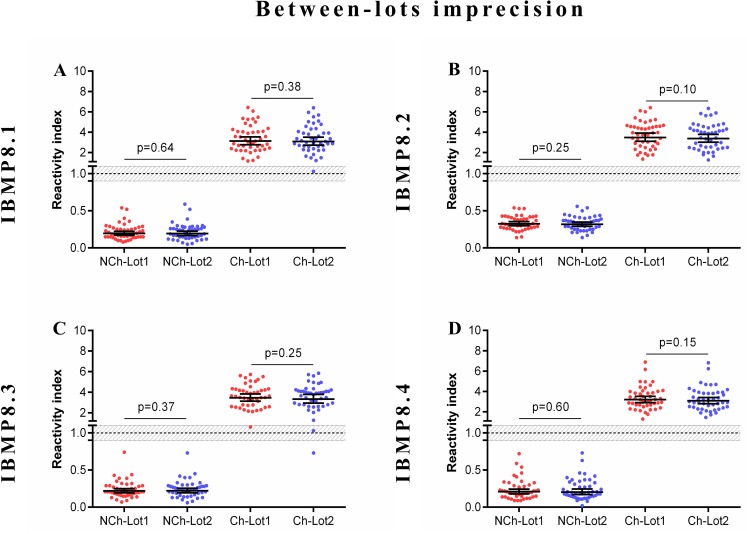
Between-lot imprecision analysis.The set of graphs shows reactivity index in chagasic (Ch) and non-chagasic (NCh) serum samples. The cut-off value was 1.0 and the shadowed area represents the grey zone (RI = 1.0 ± 0.10). Horizontal lines and numbers for each group of results represent the geometric means (± 95% CI).